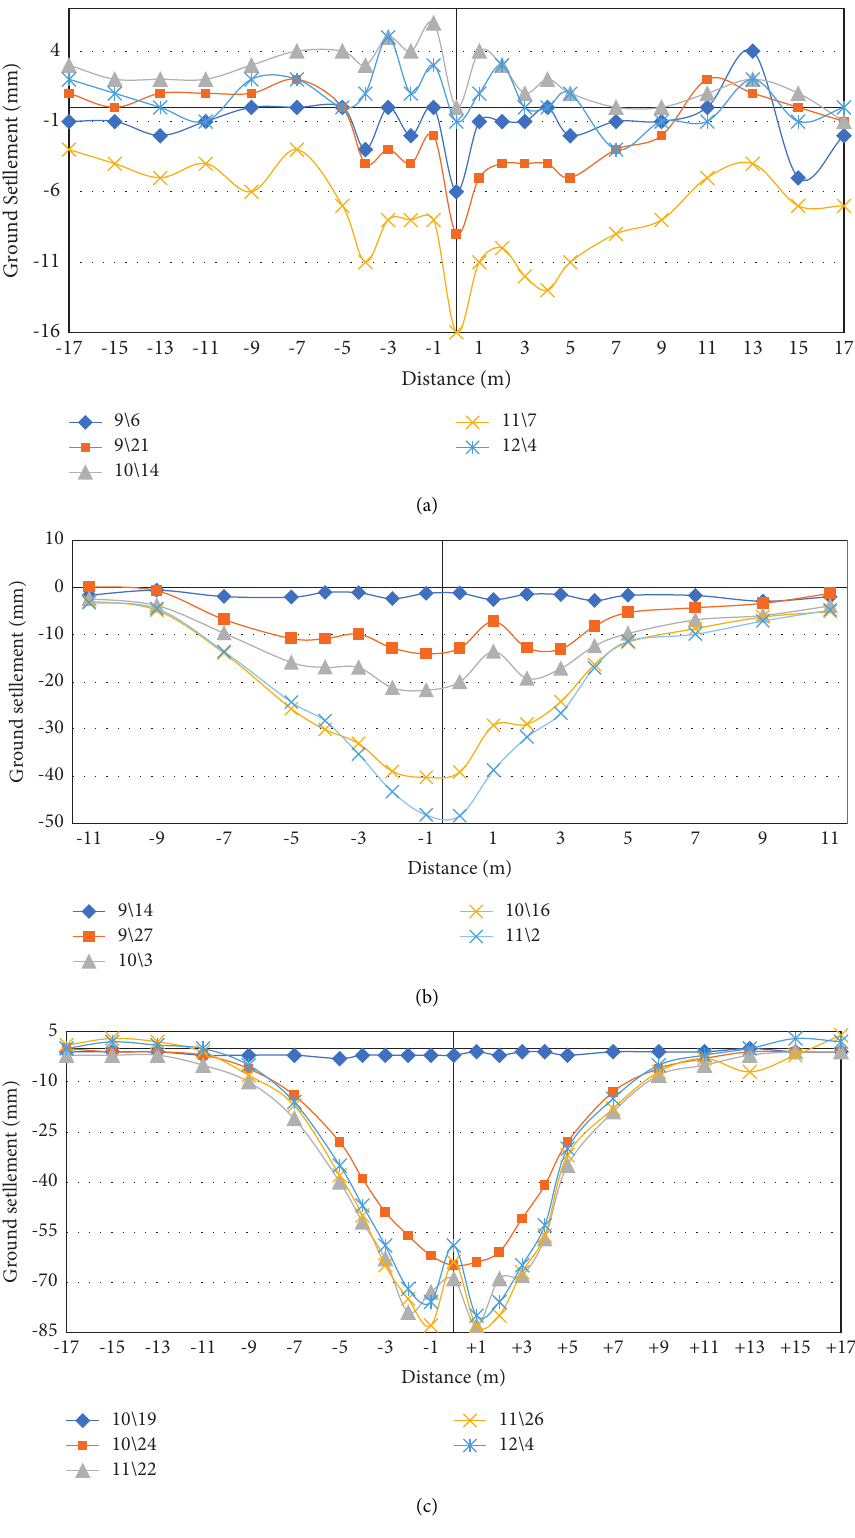
Figure 17: Curves of surface settlement trough. (a) CJ1; (b) CJ2; (c)